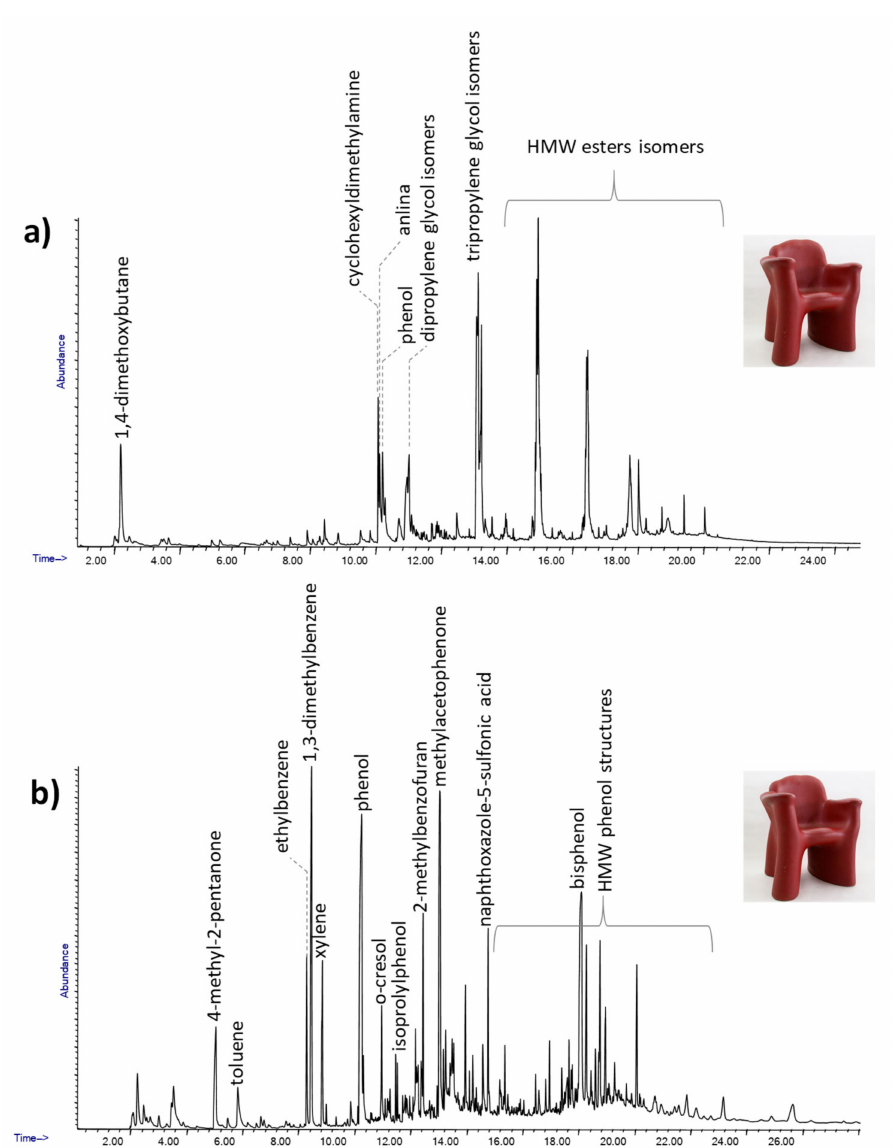
Figure 6. The Py-GC / MS chromatograms obtained for the surface ( a ) and body ( b ); samples from